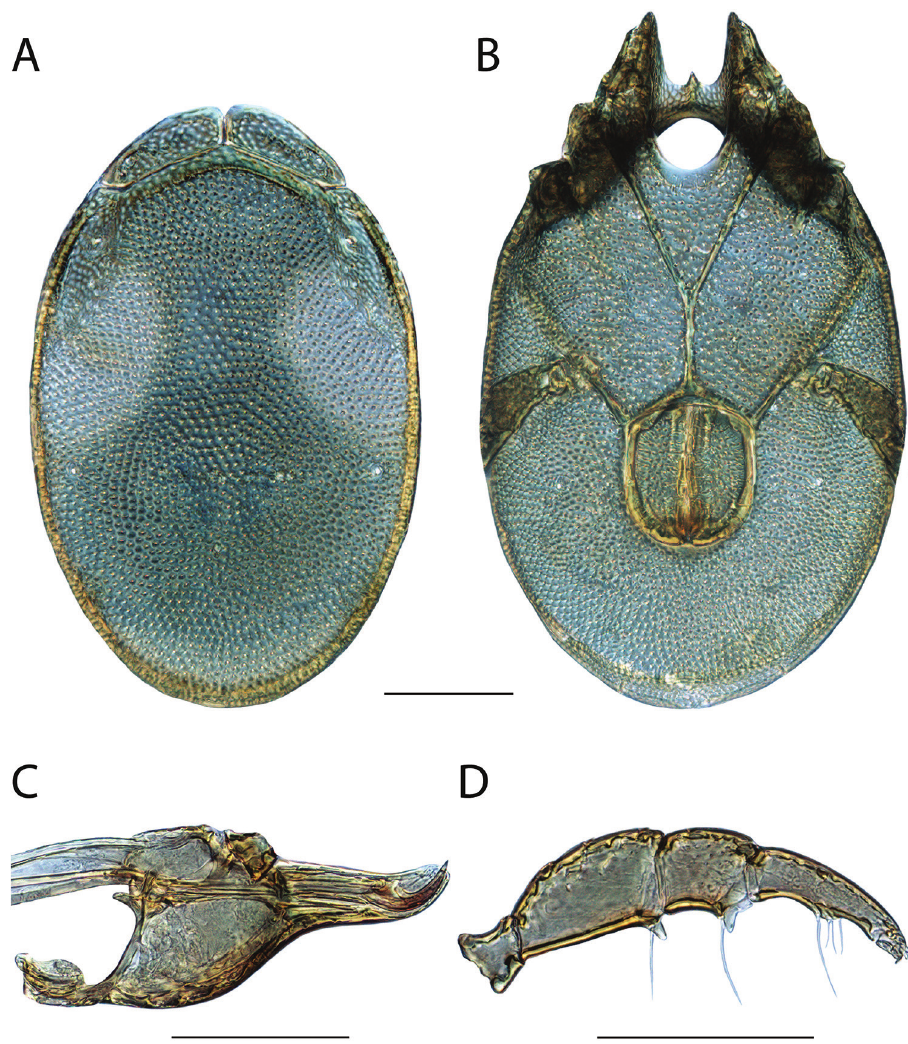
Figure 37. Torrenticola caerulea sp. n. male: A dorsal plates B venter (legs removed) C subcapitulum D pedipalp (setae not accurately depicted). Scale = 100